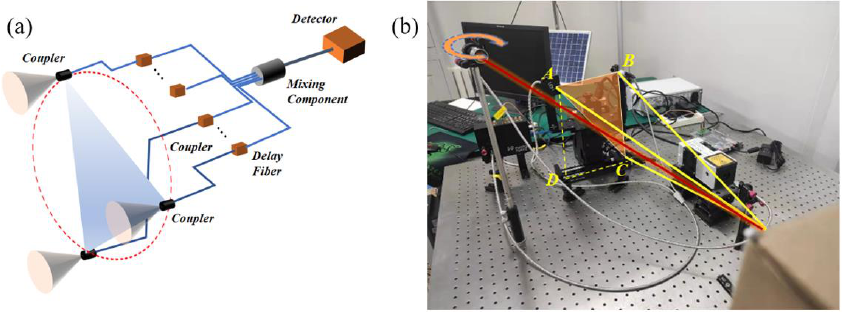
Figure 3. ( a ) Schematic of the experimental setup. ( b ) Layout of the instruments on the lab bench.